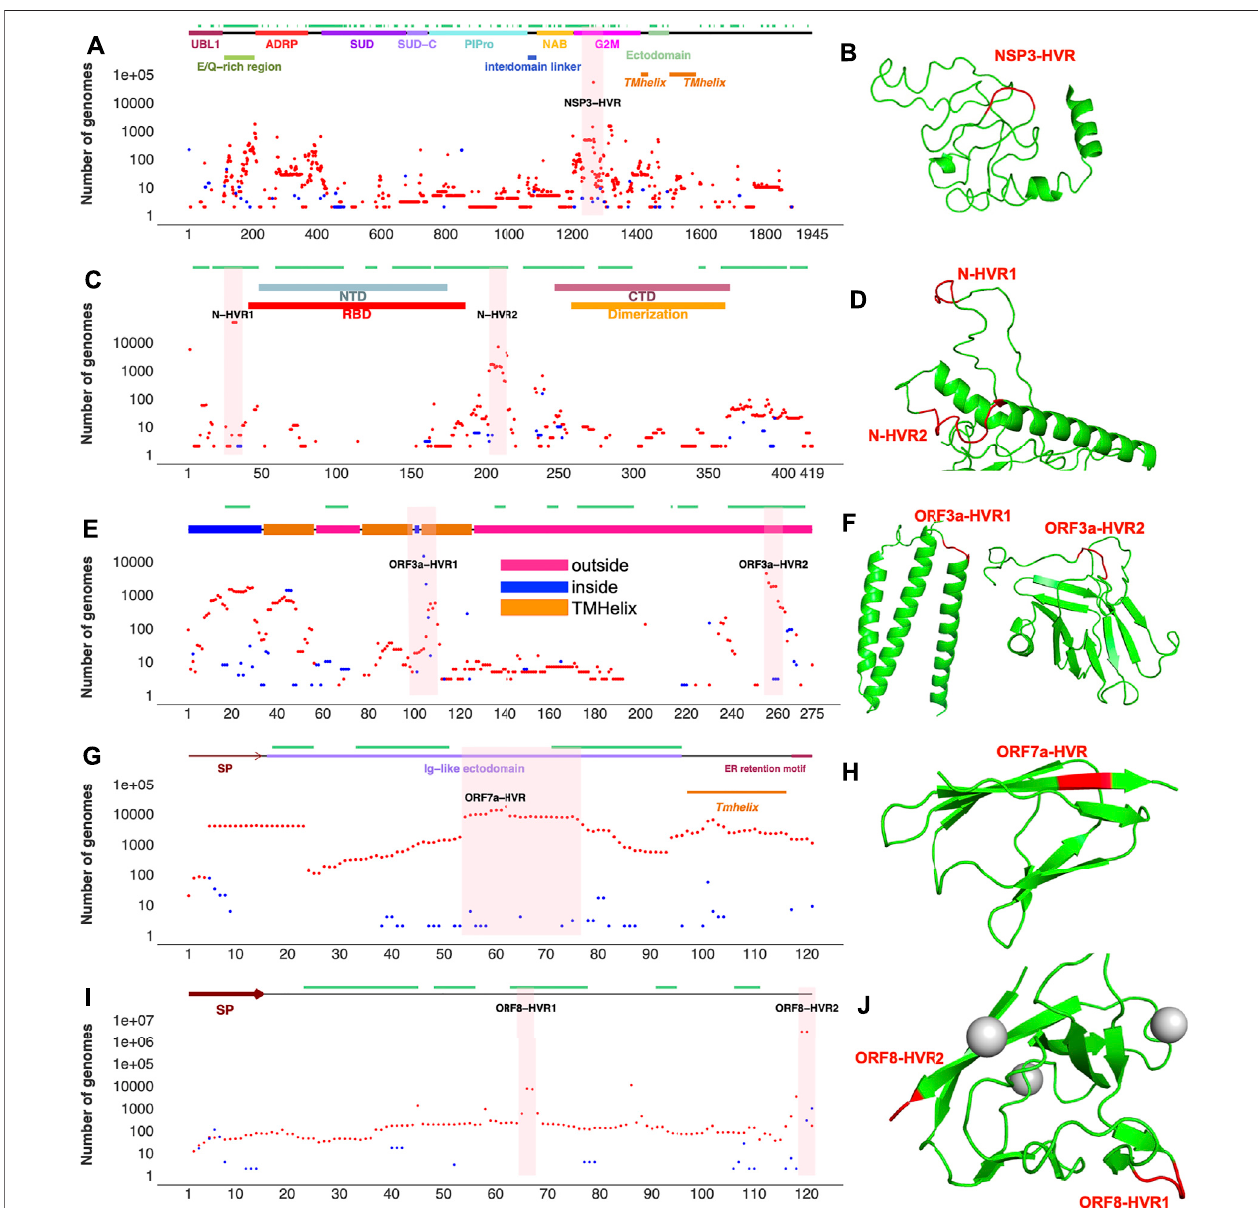
FIGURE 3 | Top SARS-CoV-2 HVRs in the context of protein 3D structures (A) Distribution of indels in SARS-CoV-2 non-structural protein 3 (NSP3) (B) NSP3 recurrent deletion region (HVR) on protein 3D structure (C) Distribution of indels in SARS-CoV-2 nucleocapsid (N) protein (D) N-HVRs on protein 3D structure (E) Distribution of indels in SARS-CoV-2 ORF3a (F) ORF3a-HVRs on protein 3D structure (G) Distribution of indels in SARS-CoV-2 ORF7a (H) ORF7-HVR on protein 3D structure (I) Distribution of indels in SARS-CoV-2 ORF8 (J) ORF8-HVRs on protein 3D structure. Deletions, insertions, and epitopes are represented as red dots, blue dots, and green lines, respectively. Pink highlighted regions represent HVRs or potential hotspots for recurrent indels in each protein. The regions of 3D structure corresponding to HVRs are colored in red. The coordinates of proteins were obtained from different sources (see Supplementary Table S3 ). Predicted 3D structural models https://zhanglab.ccmb.med.umich.edu/COVID-19/ were used for visualization of recurrent deletion regions in NSP3, ORF3a, and nucleocapsid protein. SP: signal peptide. Indels independently occur in several SARS-CoV-2 lineages in hypervariable